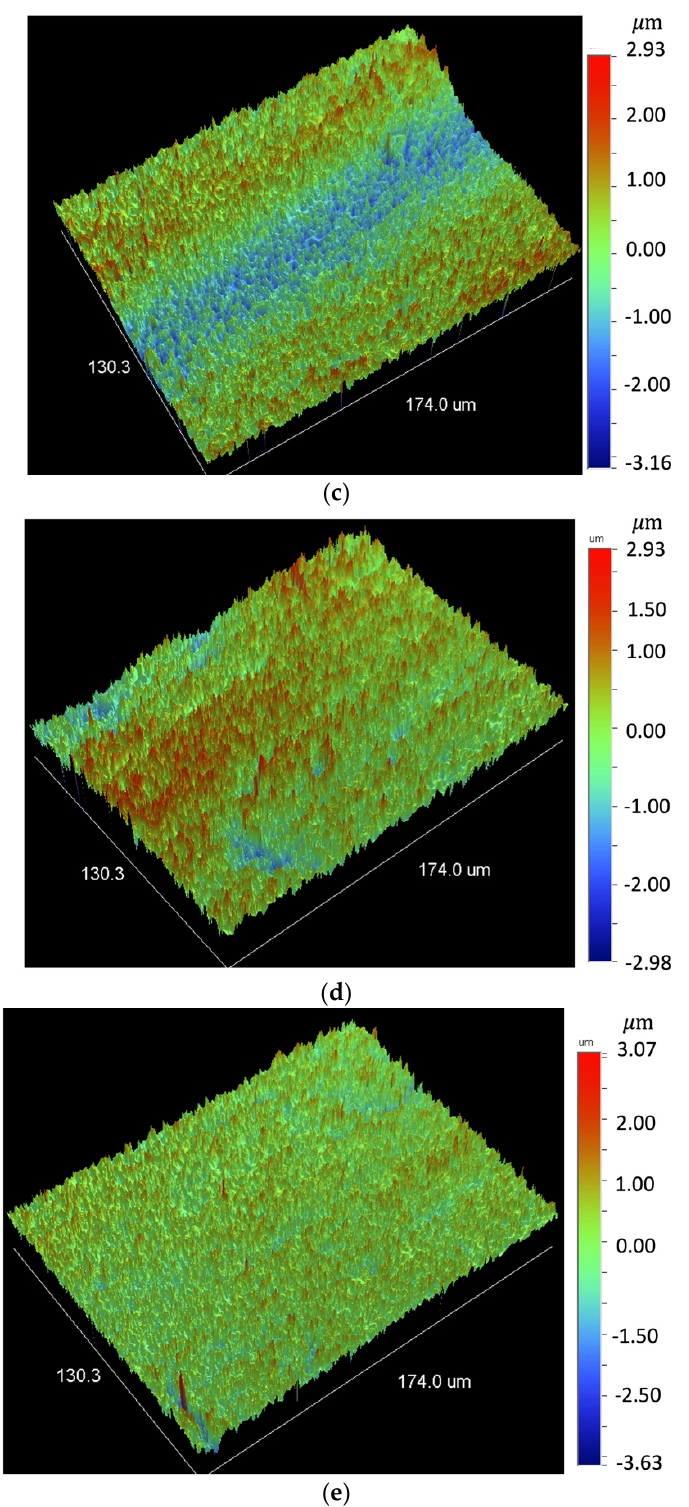
Figure 10. 3D surface profile at 50× magnification for: ( a ) as-received, unprocessed specimen and ( b – e ) spot-by-spot laser-interference processed Cu: ( b ) two pulses F 1 = 2.785 J/cm 2 per pulse, ( c ) two pulses F 1 = 1.782 J/cm 2 per pulse, ( d ) six pulses F 1 = 1.782 J/cm 2 per pulse, and ( e ) 12 pulses F 1 = 1.782 J/cm 2 per pulse.